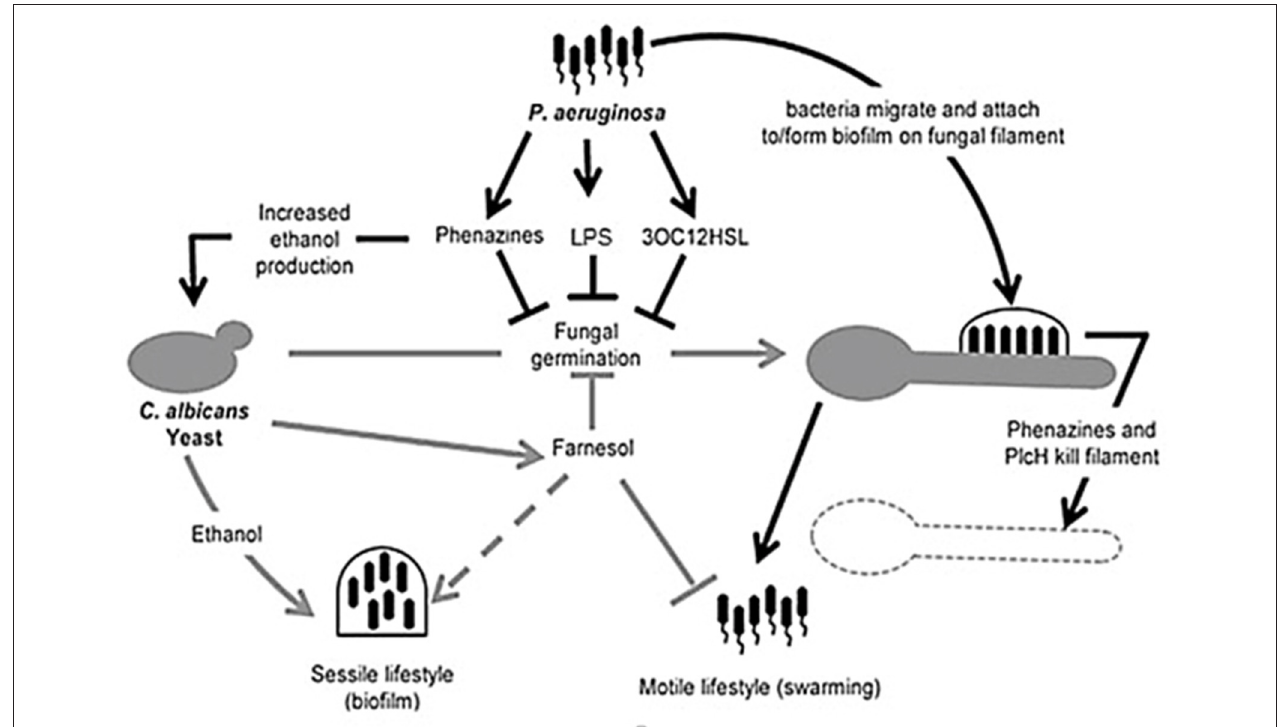
FIGURE 5 | Illustration of competition between Candida albicans and Pseudomonas aeruginosa . Pseudomonas aeruginosa attaches to C. albicans hyphae and kills hyphal cells through secreted hydrolytic enzymes such as hemolytic phospholipase C (PlcH) and phenazines such as pyocyanin and 5-methylphenazine-1-carboxylic acid (5-MPCA). 3-oxo-homoserine lactone produced by P. aeruginosa and phenazines inhibit filamentation by C. albicans , similar to farnesol, produced by C. albicans . Pseudomonas aeruginosa lipopolysaccharide (LPS) inhibits C. albicans filamentation. Ethanol production is increased by